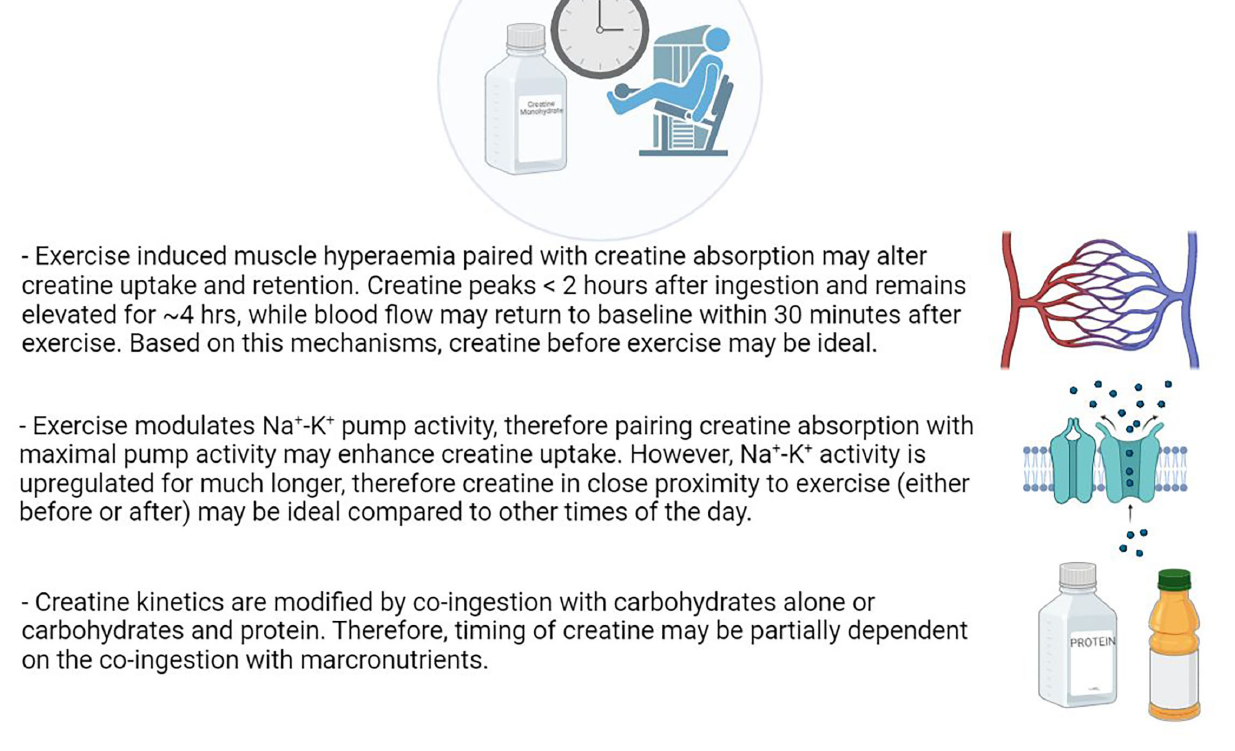
FIGURE 1 | Exercise induced muscle hyperaemia paired with creatine absorption may alter creatine uptake and retention. Creatine peaks < 2h after ingestion and remains elevated for ∼ 4h, while blood flow may return to baseline within 30min after exercise. Based on this mechanisms, creatine before exercise may be ideal. Exercise modulates Na + -K − pump activity, therefore pairing creative absorption with maximal pump activity may enhance creatine uptake. However, Na + -K + activity is upregulated for much longer, therefore re tine in close proximity to exercise (either before or after) may be ideal compared to other time of the day. Creatine kinetics are modified by co-ingestion with carbohydrates alone or carbohydrates and protein. Therefore, timing of creatine may be partially dependent on the co-ingestion with marconutrients. Created with BioRender.com.